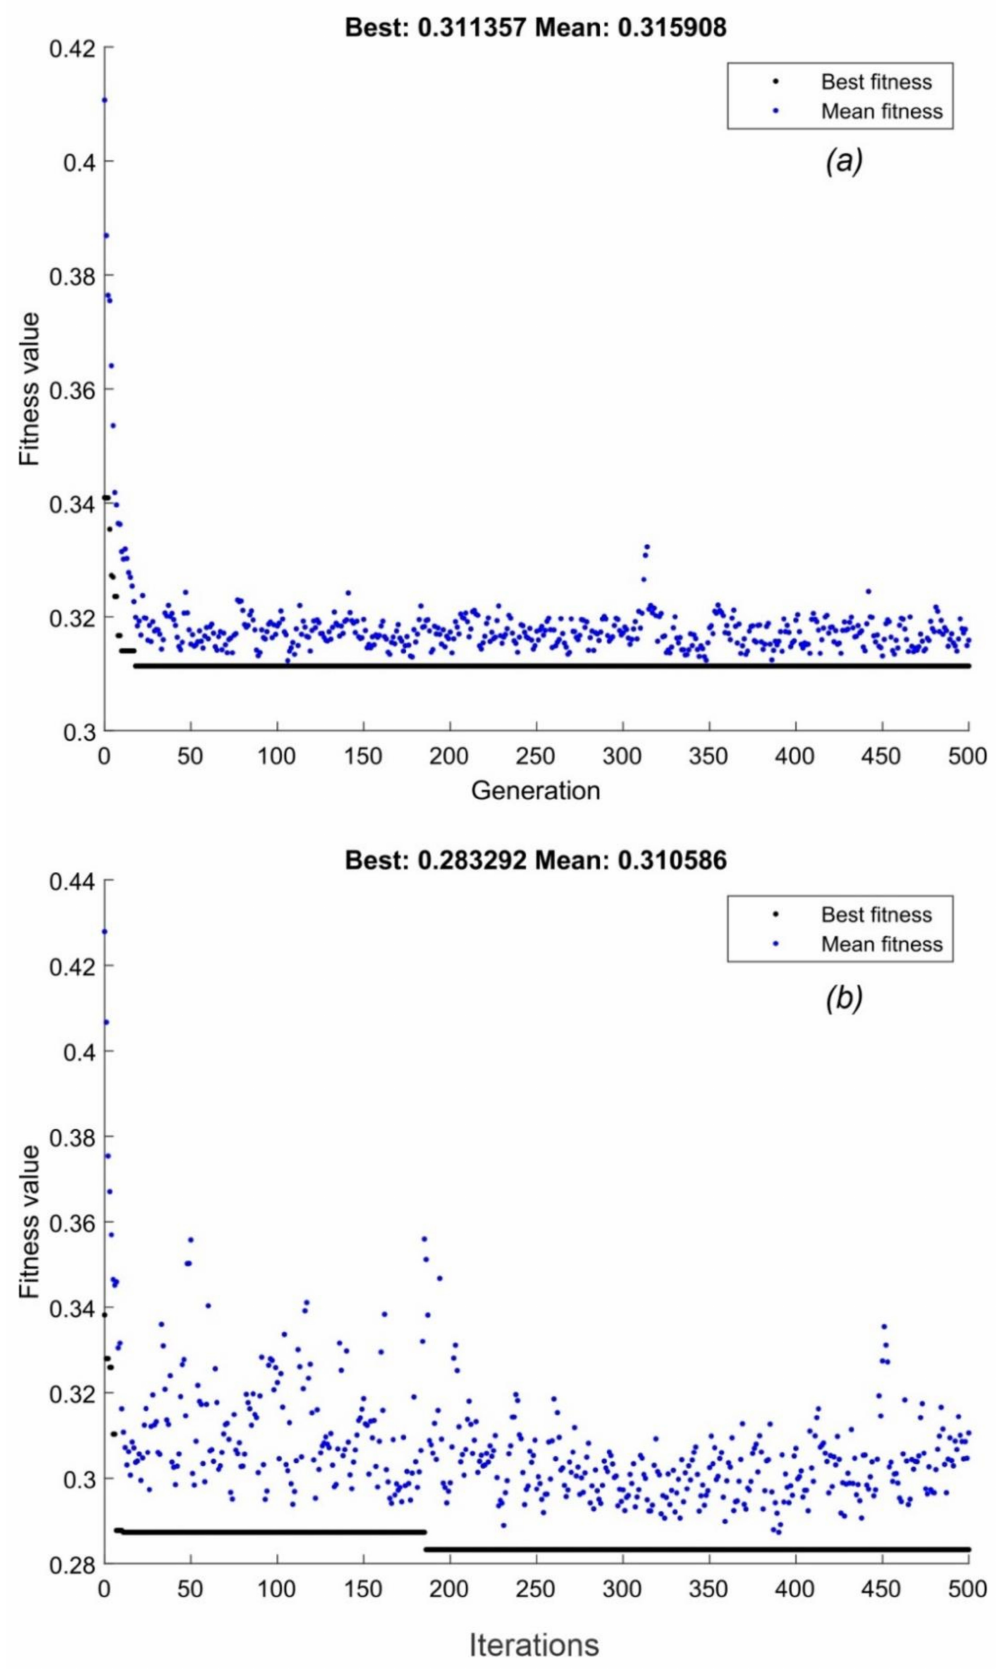
Figure 7. Convergence plot of ( a ) SVR-WOA and ( b ) SVR-SA